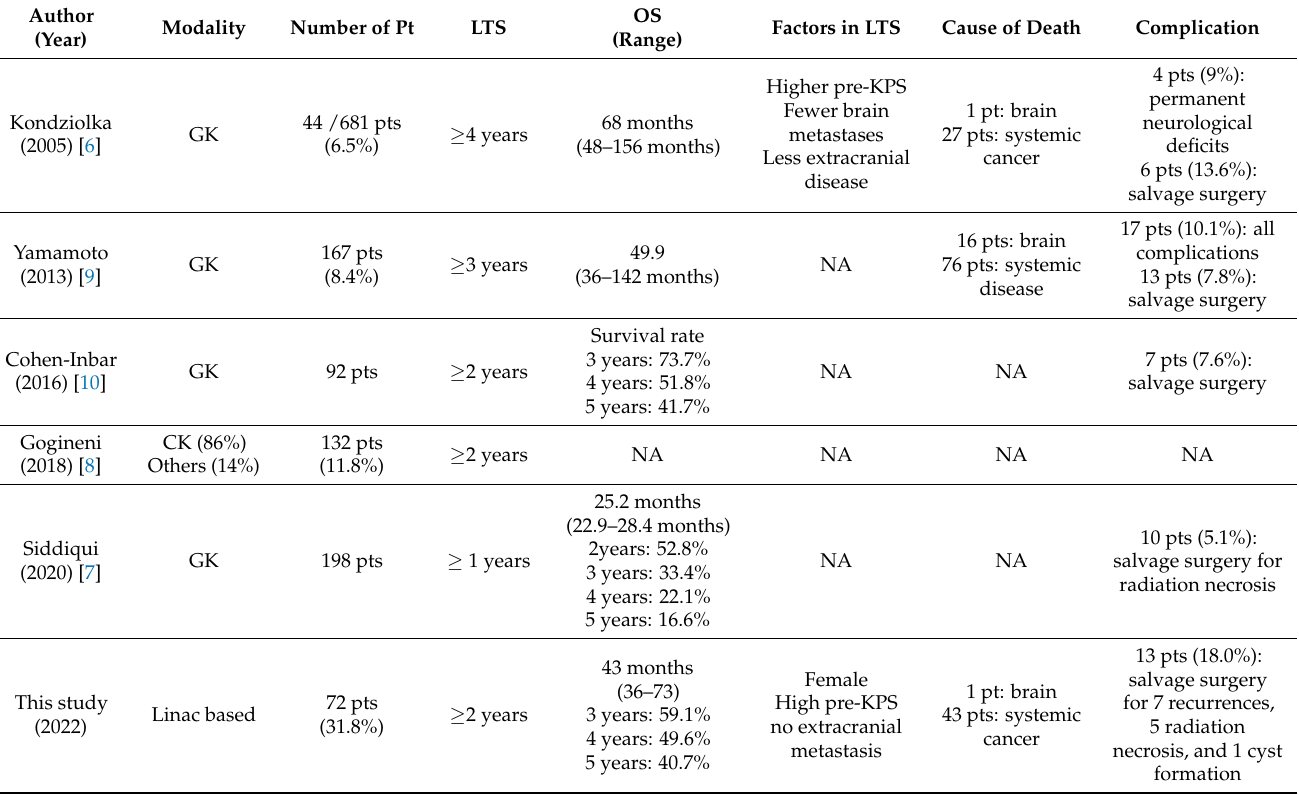
Table 4. Summary of SRS/fSRT for long-term survivors after SRS and